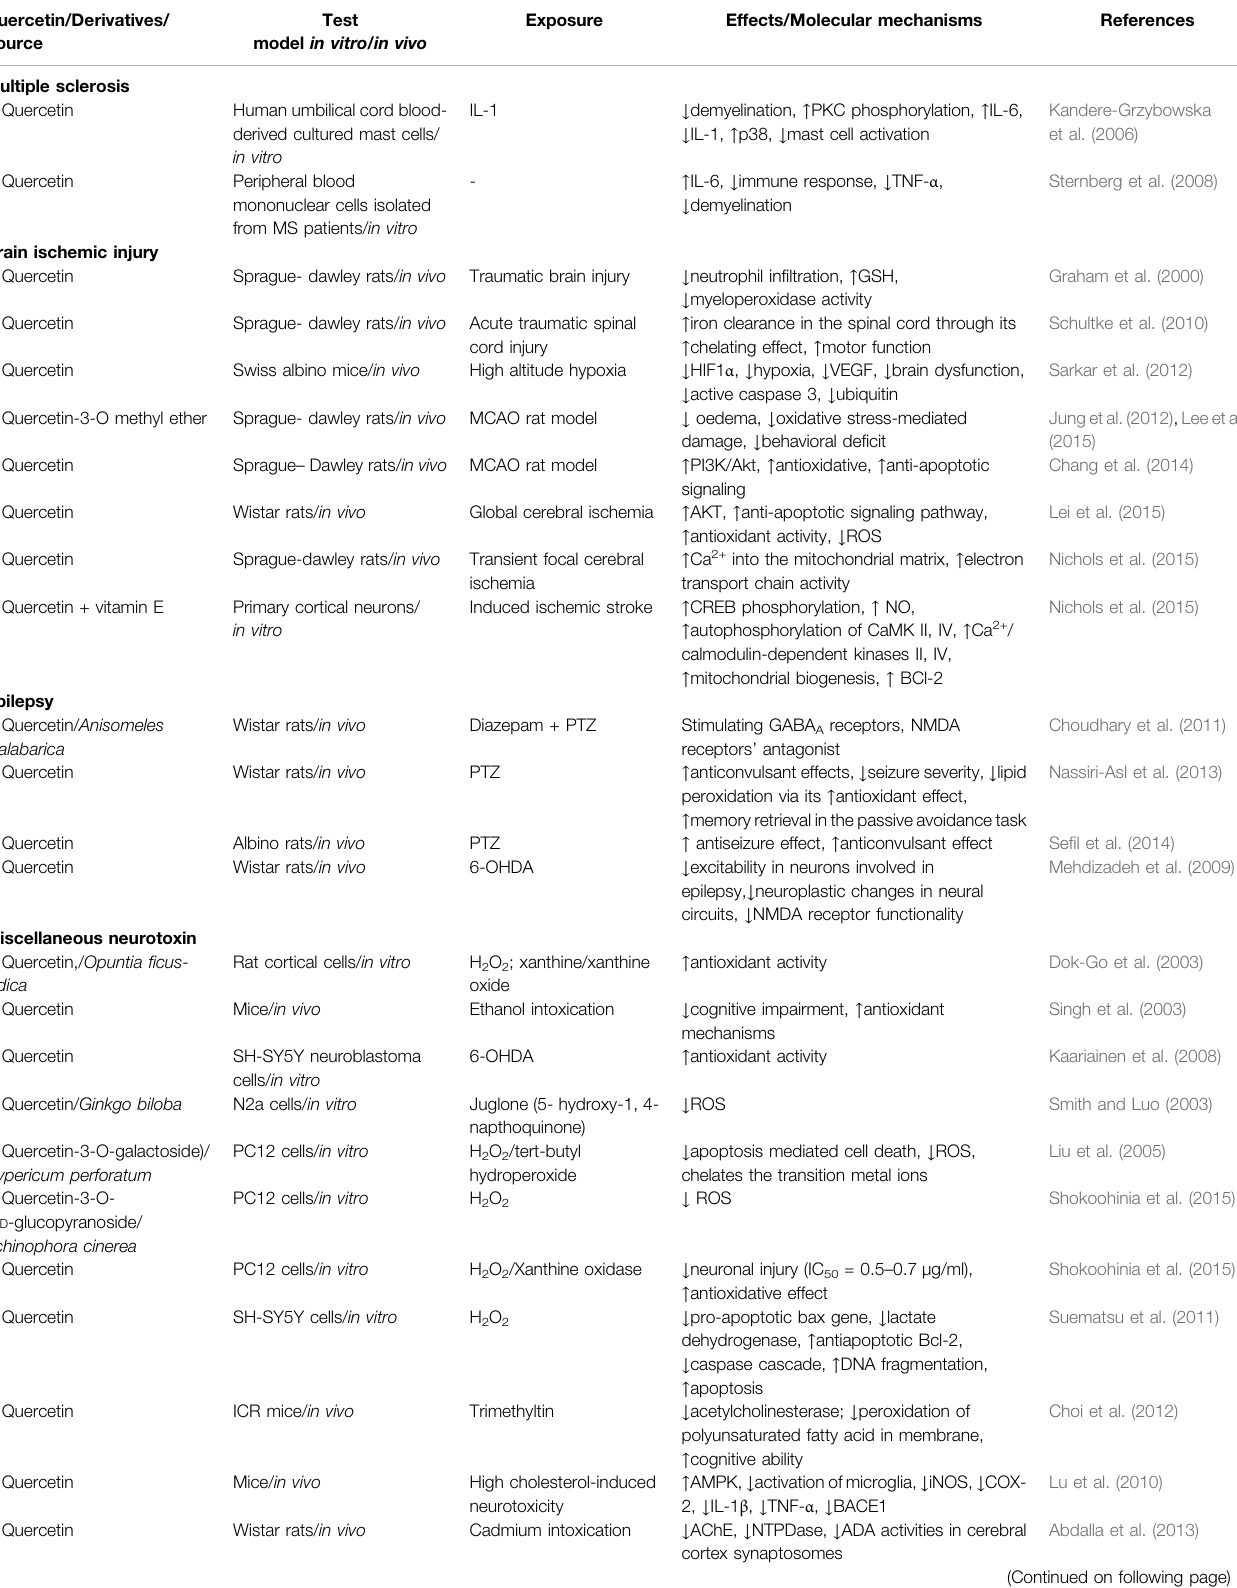
TABLE 1 | ( Continued ) Neuroprotective effects of quercetin and/or its derivatives against various neurodegenerative diseases and other brain